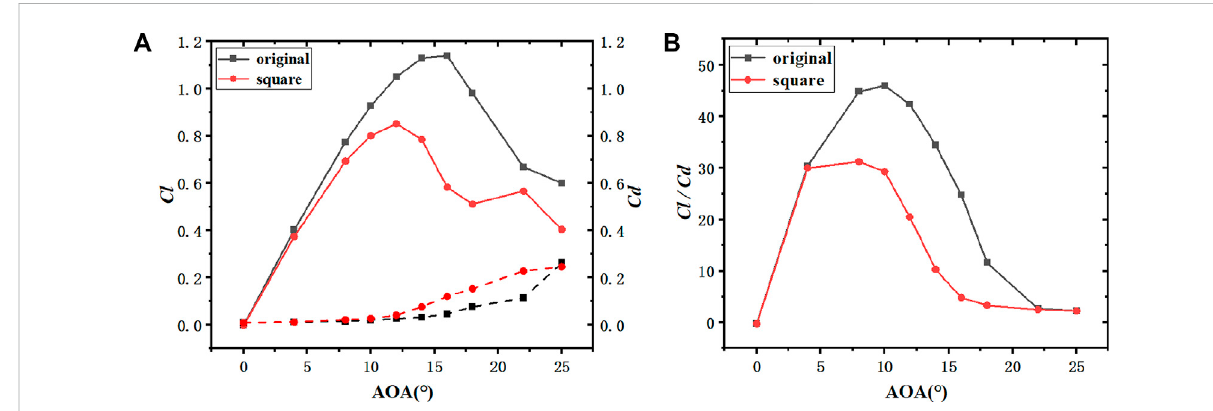
FIGURE 15 ComparisonofaerodynamiccharacteristicsbetweenNACA0018originalairfoilandsquareerosionleadingedgeairfoil( h 2 =0.5% c ).( (A) :Liftand drag coef fi cient; (B) : Lift-drag ratio coef fi